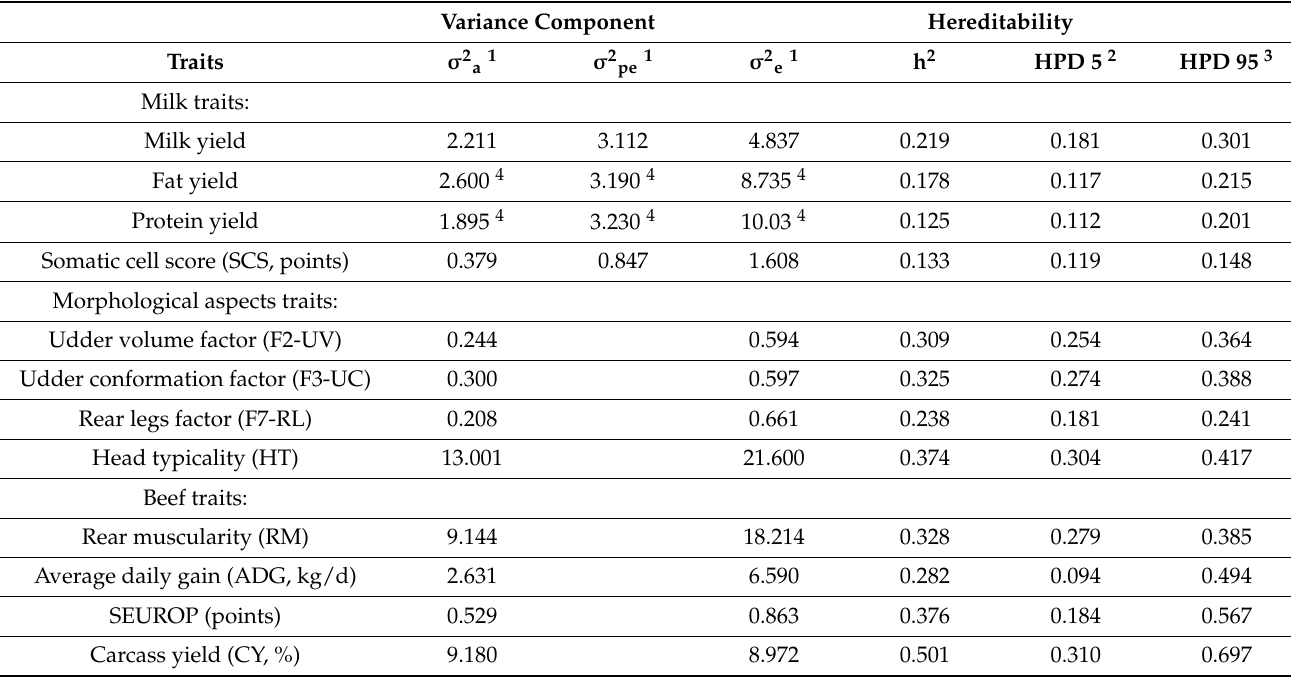
Table 3. Estimates of variance components and heritability (h 2 ) of analyzed traits as the means and HPD of the marginal posterior densities. Note that not all traits possess all three components (e.g., udder volume factor does not have a σ 2 pe , i.e., permanent environment